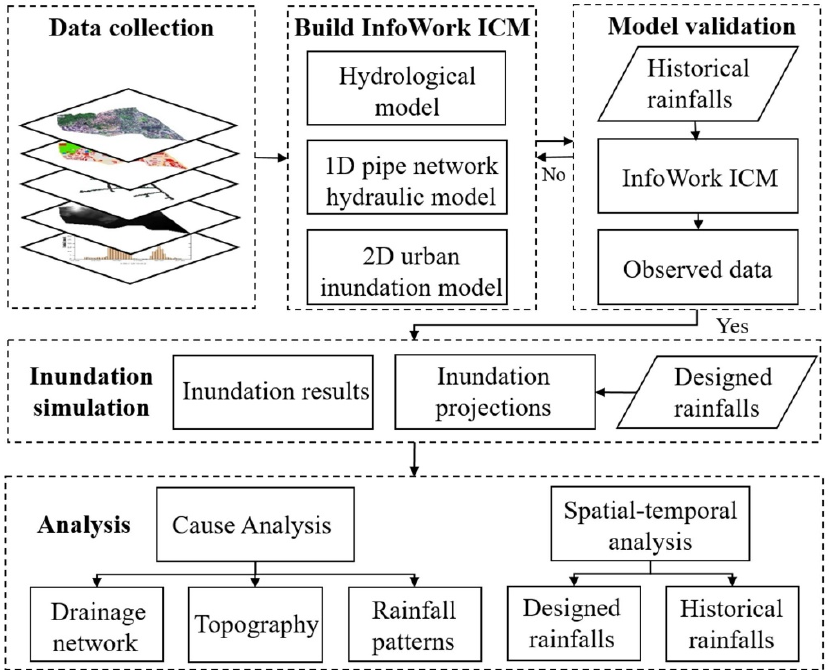
Figure 3. Technical flowchart.